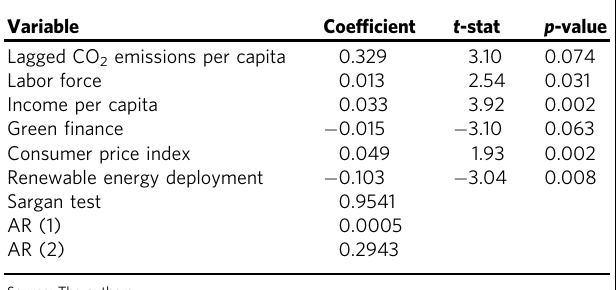
Table 4 System GMM estimations for all examined provinces in China.